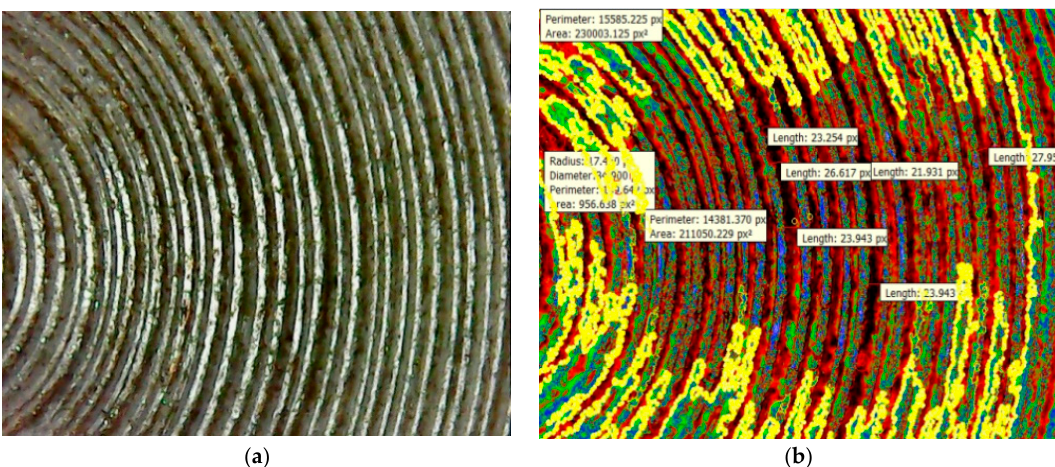
Figure 17. ( a ) Peaks and valleys at Al-Cu interface. ( b ) Segment based analysis of the welded region.